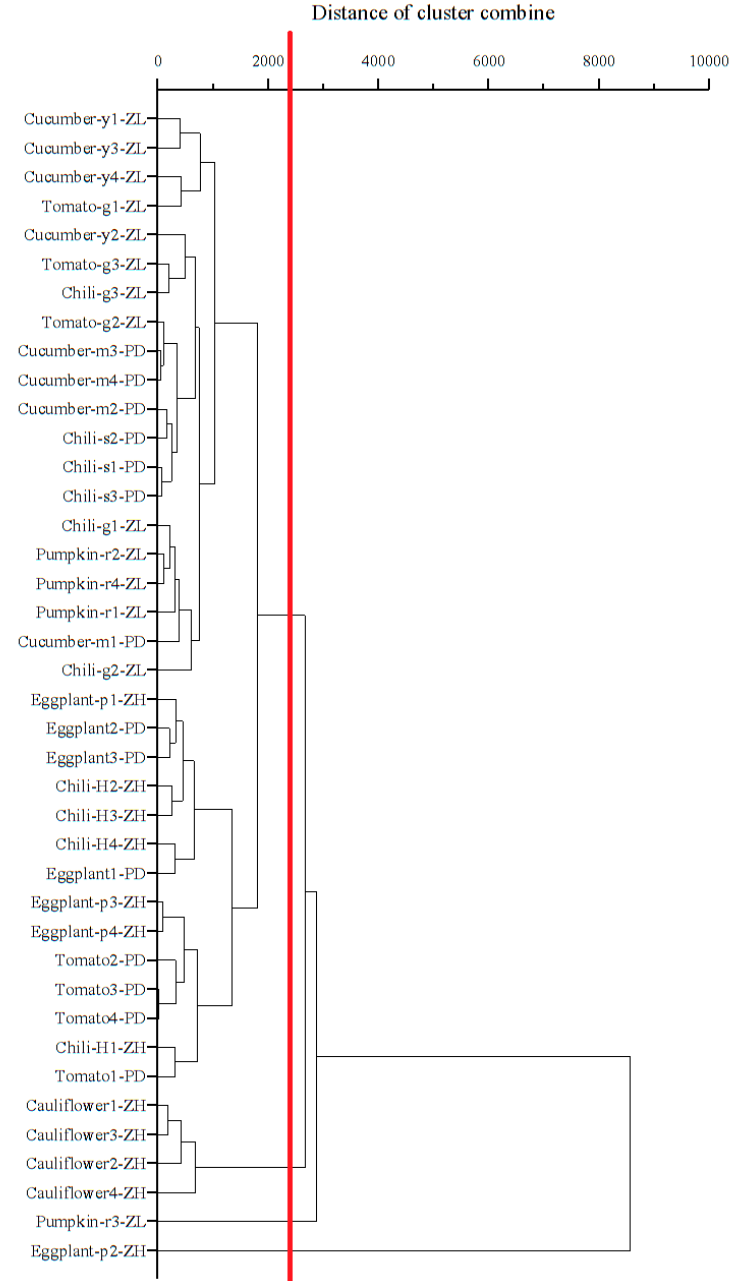
Figure 4. Cluster analysis of PAEs in vegetable foliar samples collected from the three study areas. Cucumber-y1-ZL, the first sampling greenhouse planted cucumber (yellow) / yellow cucumber in Zilingpu; Tomato-g1-ZL, the first sampling greenhouse planted tomato (green) / green tomato in Zilingpu; Chili-g1-ZL, the first sampling greenhouse planted chili (green) / green chili in Zilingpu; Pumpkin-r1-ZL, the first sampling greenhouse planted pumpkin (red chestnut) / red chestnut pumpkin in Zilingpu; Eggplant-p1-ZH, the first sampling greenhouse planted eggplant (purple long) / purple long eggplant in Zhanghe; Chili-H1-ZH, the first sampling greenhouse planted chili (Hangzhou) / Hangzhou chili in Zhanghe; Cauliflower-1-ZH, the first sampling greenhouse planted cauliflower in Zhanghe; Tomato-1-PD, the first sampling greenhouse planted tomato in Pengdun; Cucumber-m1-PD, the first sampling greenhouse planted cucumber (mini) / mini-cucumber in Pengdun; Eggplant-1-PD, the first sampling greenhouse planted eggplant in Pengdun; Chili-s1-PD, the first sampling greenhouse planted chili (screw) / screw chili in